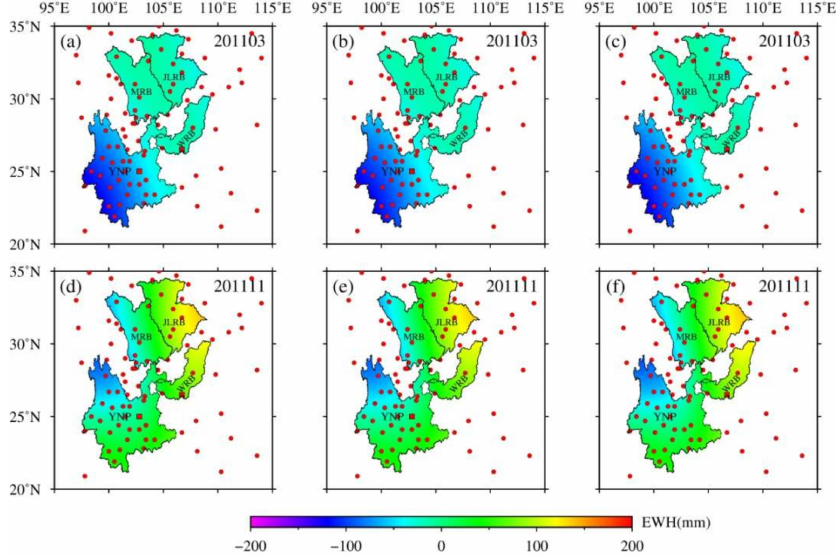
Figure 4. Surface mass variations inverted by simulated GPS vertical displacements in March (top) and November (bottom) 2011, respectively. ( a ) and ( d ) show the spatial distributions inverted from a total of 85 GPS stations; ( b ) and ( e ) show the spatial distributions inverted from those GPS stations without GZGY; ( c ) and ( f ) show the spatial distributions inverted from those GPS stations without KMIN. The red dots represent the location of GPS stations, but the locations of GZGY and KMIN are indicated as red